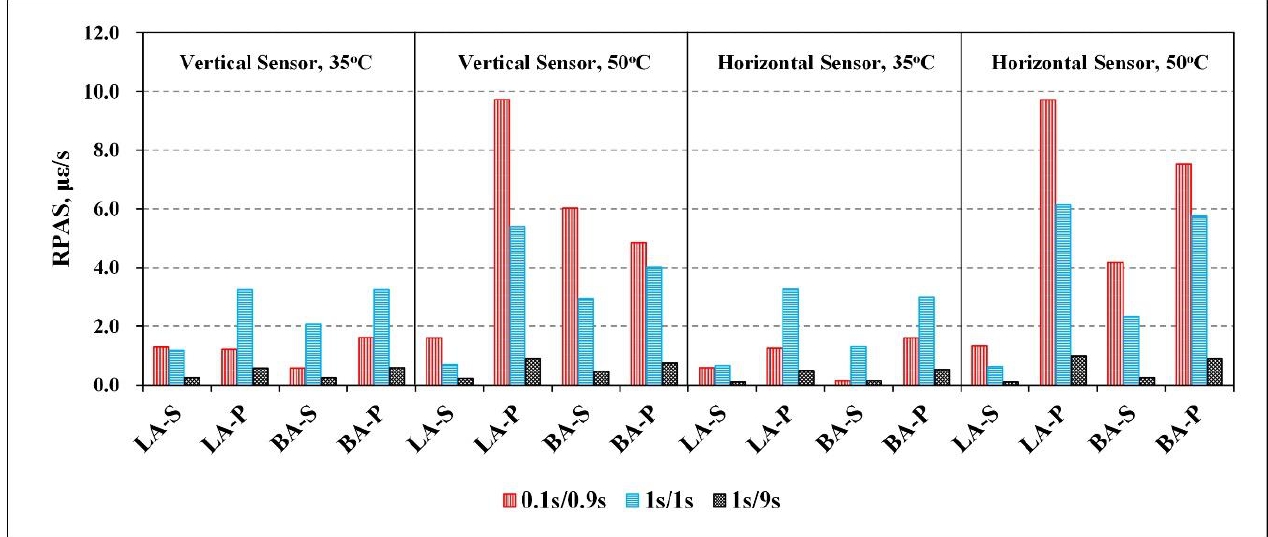
Figure 8. Longitudinal and lateral RPS of mixes at 35 °C and 50 °C under different loading/rest time combinations. Table 8. The value range of RPS for the four mixtures at 35 °C and 50 °C.